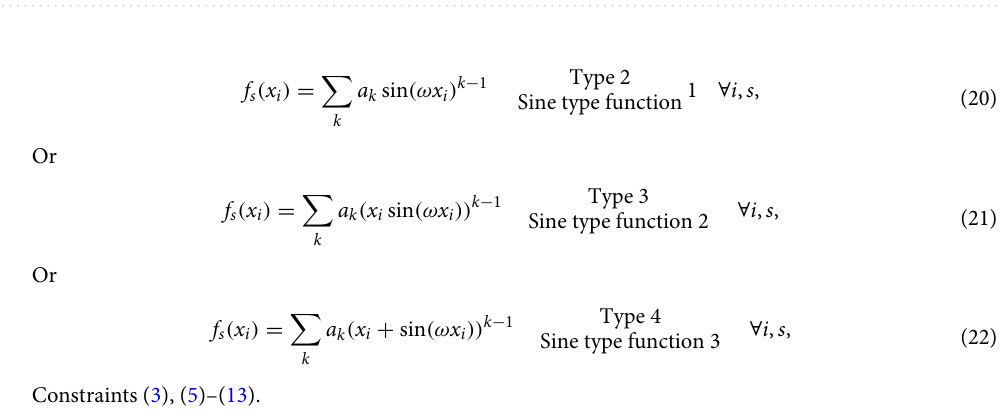
Figure 4. Agri-food